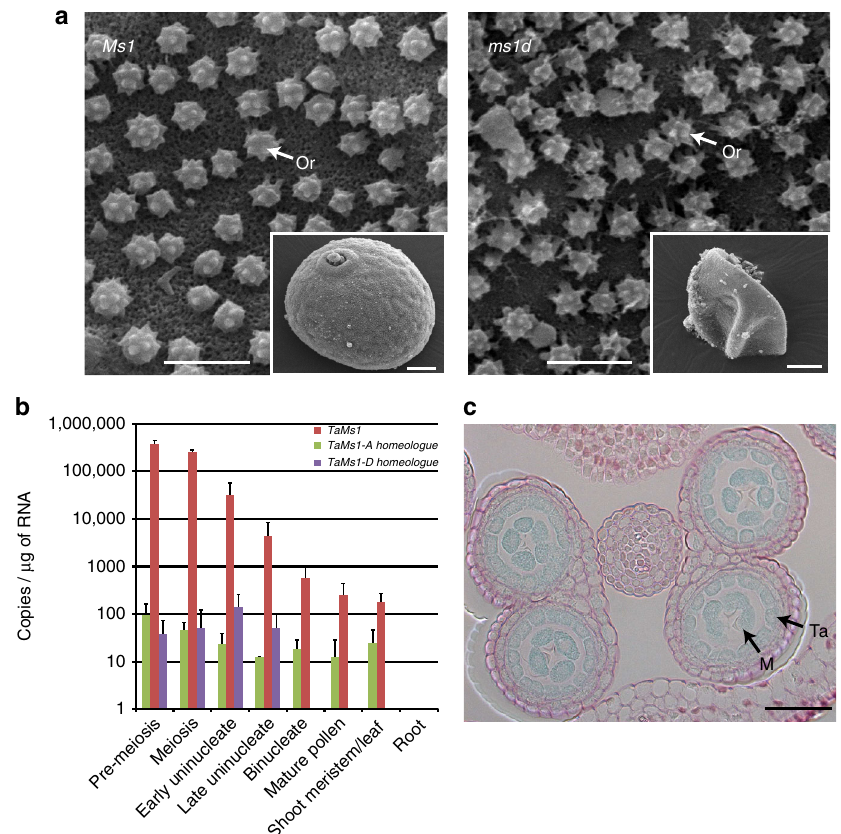
Fig. 2 TaMs1 confers male fertility and is expressed in developing wheat anthers. a Scanning electron micrographs showing the defects in tapetal cell surface-localised orbicule (Or) structures and pollen coat (inset) within male sterile ( ms1d ) vs. wild-type anthers ( Ms1 ). Scale bars: 2 µ m (inset 10 µ m). b TaMs1 and homeologue mRNA levels as detected by qRT-PCR in premeiotic to mature pollen-containing anthers, leaf/shoot apical meristem and roots. The data are means ± s.e.m (n = 3 biological replicates). c Histochemical GUS analysis of wheat anthers expressing a translational GUS fusion with TaMs1 (native promoter). Transverse section of a wheat anther containing microspores undergoing meiosis showing cell-type-speci fi c GUS expression. Ruthenium red-stained cell walls (pink). Scale bar: 50 µ m. (Ta Tapetal cell, M